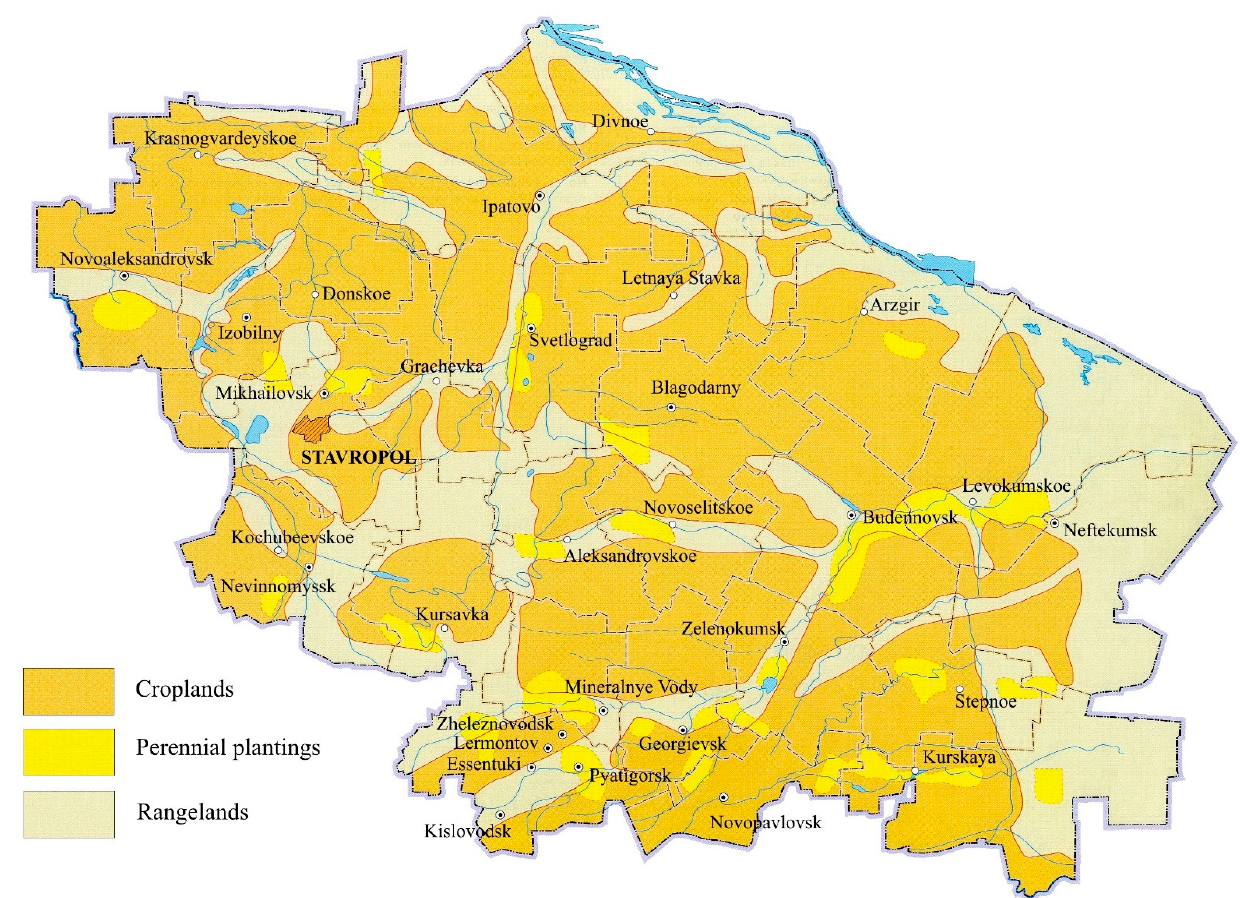
Figure A2. Stavropol Krai: Allocation of agricultural lands. Source: authors’ development.